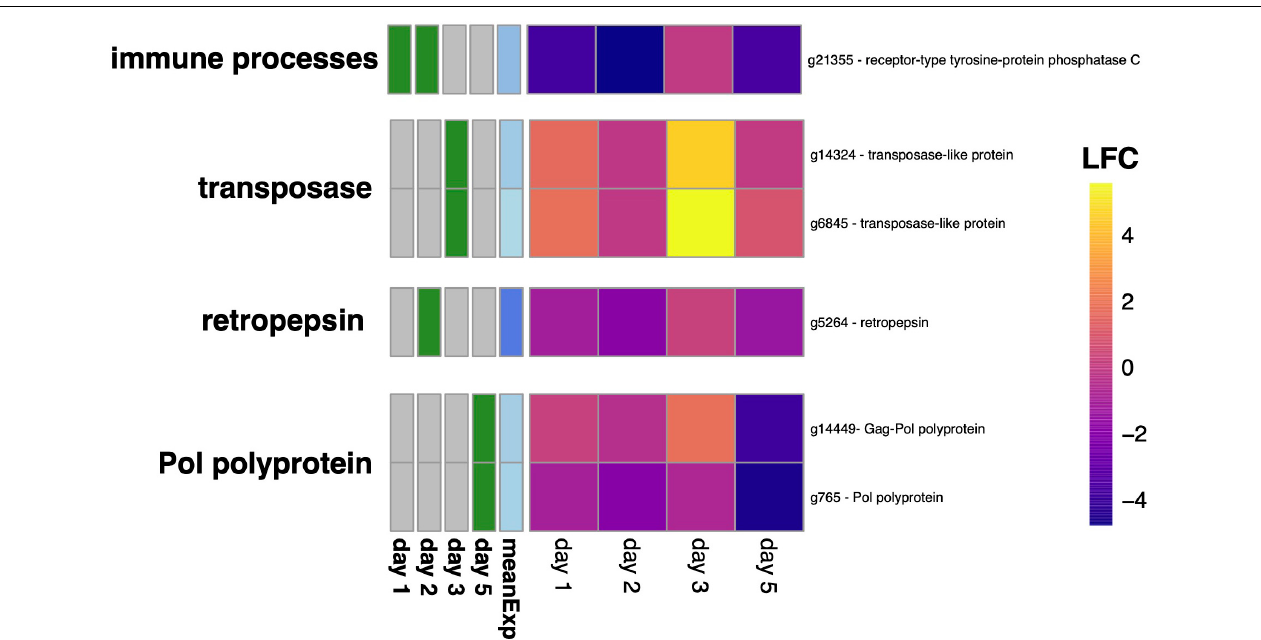
FIGURE 4 | Differential expression of genes involved in DNA recombination (GO:0006310 - DNA recombination). The heatmap shows the log-fold change (LFC) of Texel oysters relative to Sylt oysters with a significant up-regulation of transposase genes on day 3 and down-regulation of genes of viral origin (retropepsin on day 2 and Pol polyproteins on day